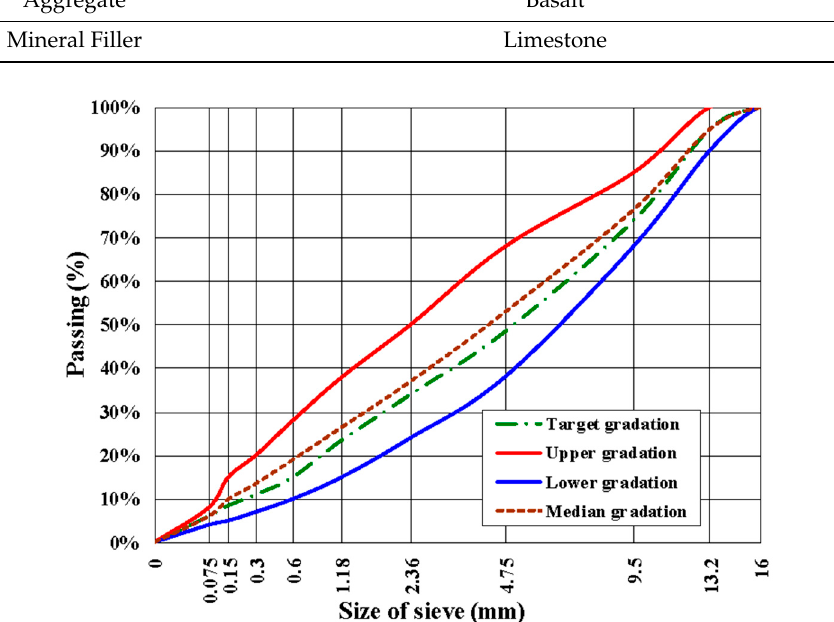
Table 5. Marshall Test results at optimal asphalt content.